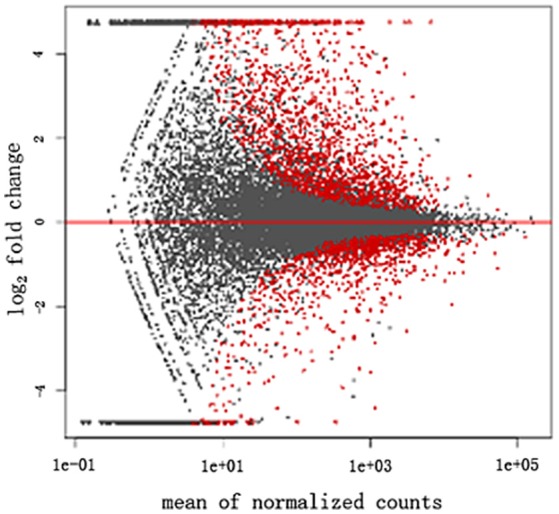
Volcano plot of the differentially displayed genes in tomato.